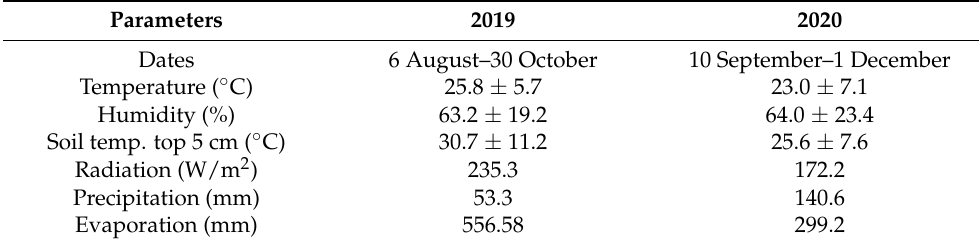
Table 2. Meteorological data for the 2019 and 2020 experiments 1